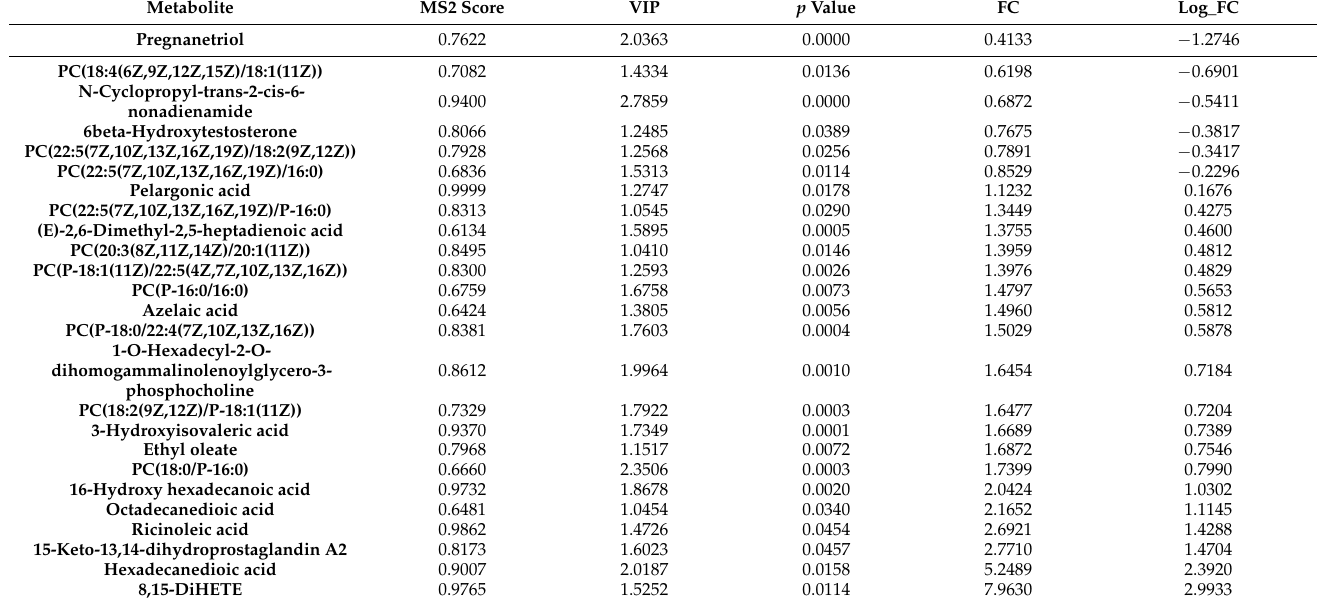
Table 3. List of differential lipids identified in the untargeted metabolomic